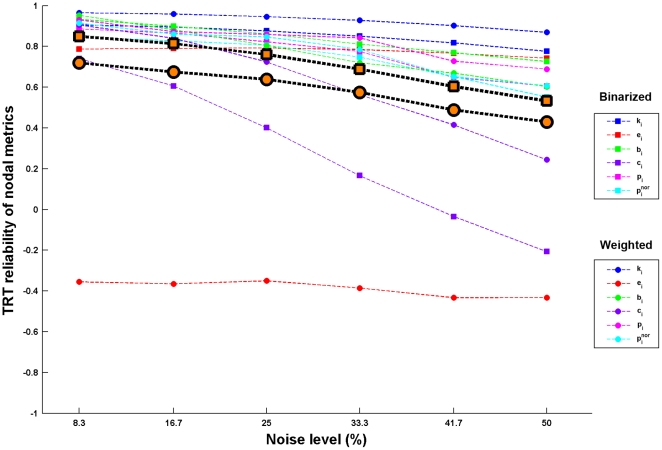
TRT reliability of nodal network metrics as a function of noise in RSFC for S-AAL-based networks.Nodal network metrics were sensitive to disturbances of RSFC and no differences were observed in the resistance to noise in functional connectivity between binarized and weighted network analysis. The highlighted black border marks are the average reliability across metrics for binarized (square) and weighted (circle) network analysis, respectively. Of note, although sensitive, nodal network metrics showed strong tolerance of disturbances in RSFC. TRT, test-retest; RSFC, resting-state functional connectivity.